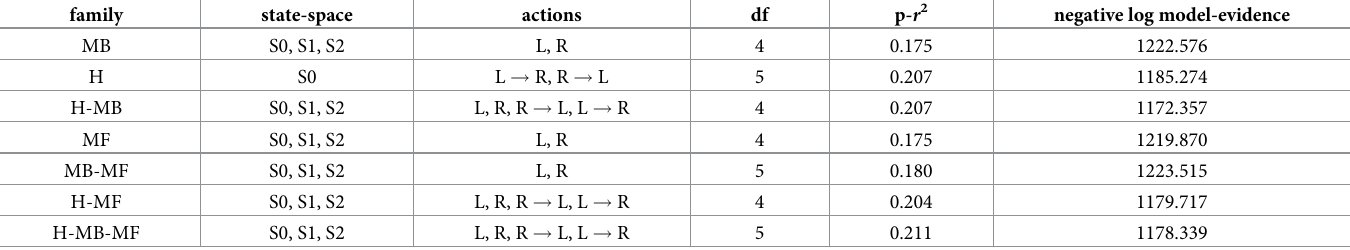
Table 3. States and actions for each family of computational model along with degrees-of-freedom (df), pseudo- r 2 , and negative log model-evidence ( − log p ( D | M )) for the best model in each family; lower values of negative log model-evidence are better.